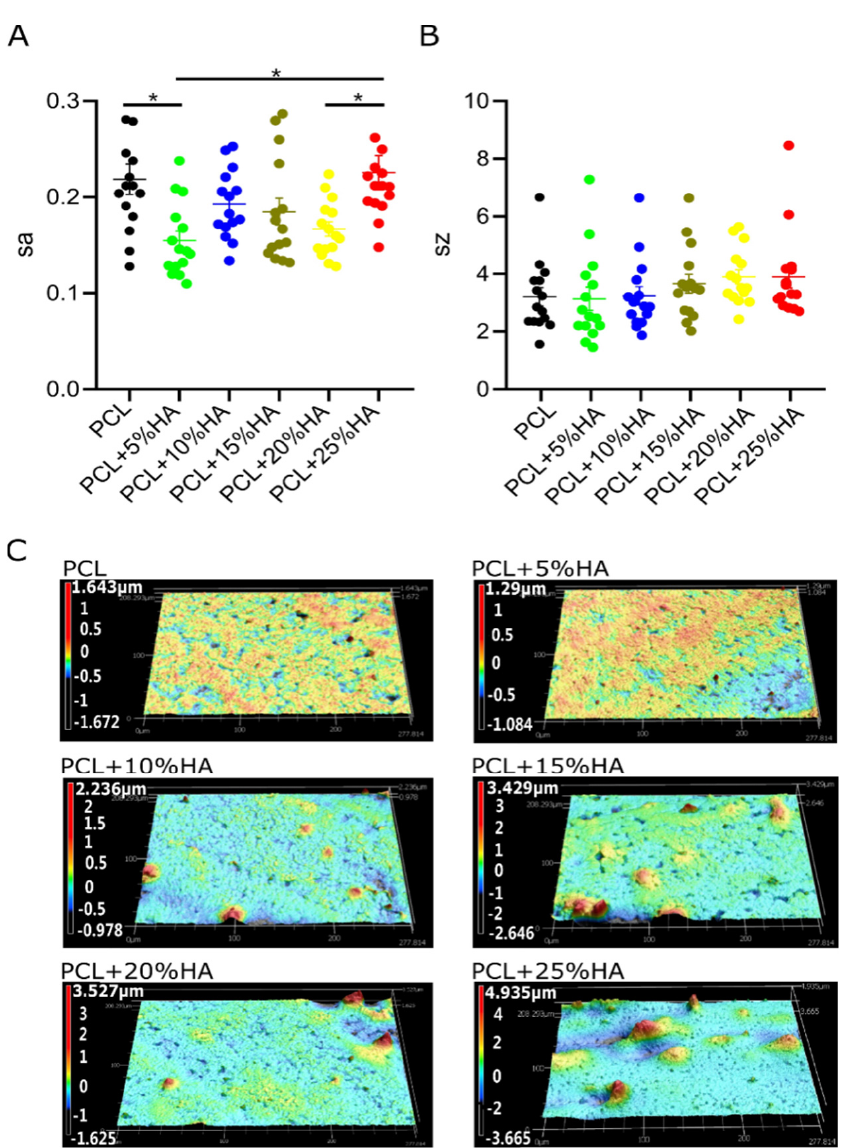
Figure 4. Surface roughness analysis of the six groups’ scaffolds. ( A ) Graph on the left side represents Sa (arithmetical mean height); ( B ) Graph on the right represents Sz values (maximum height of surface). Graphs show mean ± s.e.m, * = p < 0.05, one-way ANOVA + Tukey’s post hoc test ( n = 5). ( C ) Surface topography of the six groups. Pseudo-color blue = valleys, pseudo-color red = peaks.